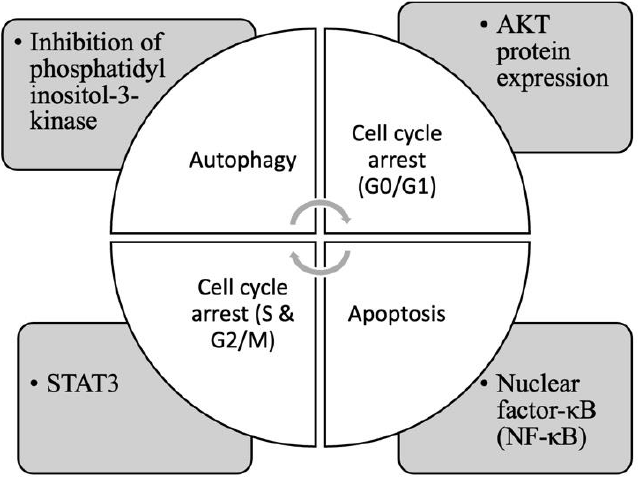
Figure 2. Linear and angular groups of furanocoumarins: ( a ) psoralen; ( b ) bergapten; ( c ) methoxsalen; ( d ) angelicin; ( e ) pimpinellin; and ( f ) sphondin.